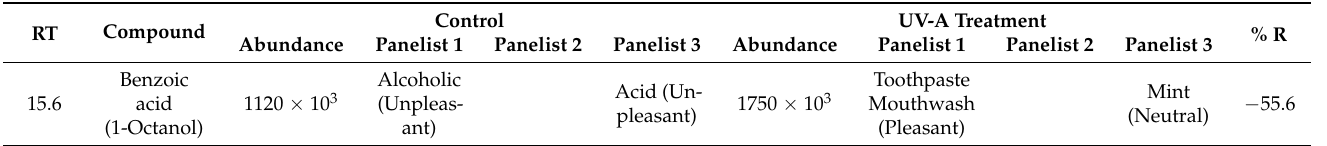
Table 14. Results of simultaneous chemical and smell sensory characterization of selected VOCs emitted from swine manure and treated with UV-A. Panelist responses are the ‘odor character (i.e., ‘what it smells like’) and the (hedonic tone) (on an ‘unpleasant-neutral-pleasant’ scale).